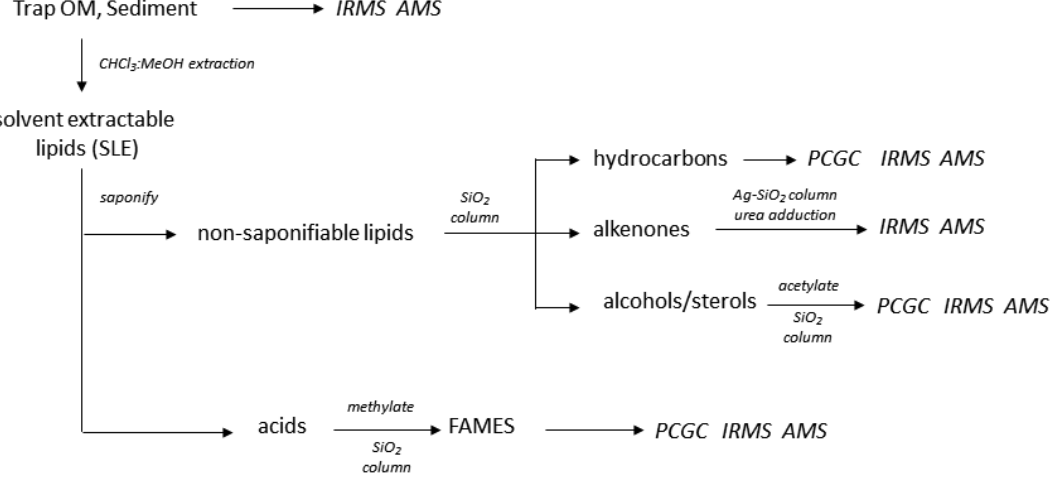
Figure 2. Scheme of extraction, isolation and analysis of